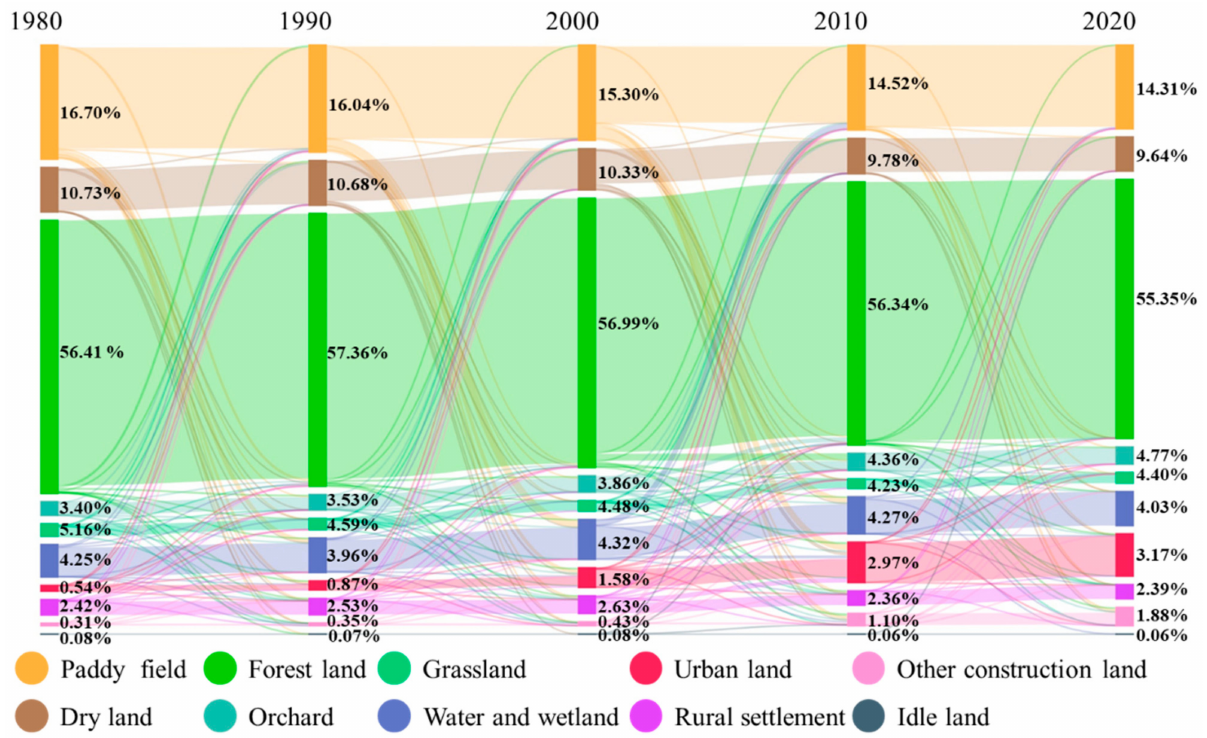
Figure 3. Dynamic change of land use in Guangdong from 1980 to 2020. (Note: The percentage in the figure indicates area proportion of each land use